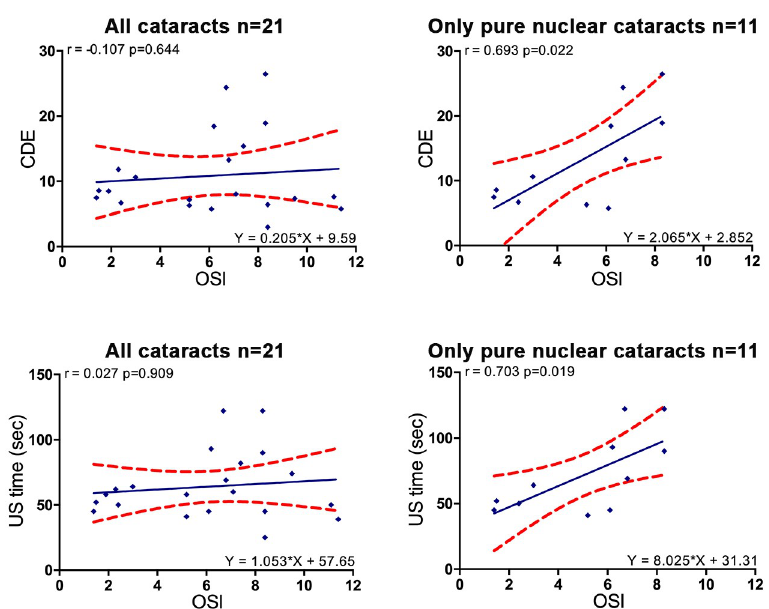
Fig 4. Linear regressions between OSI and surgical parameters for all cataracts and for pure nuclear cataracts. Red dots show the 95% CI of the slope and intercept. OSI = objective scatter index, US = ultrasound, CDE = cumulative dissipated energy, LOCS III = lens opacity classification system III, N pure = pure nuclear cataract.